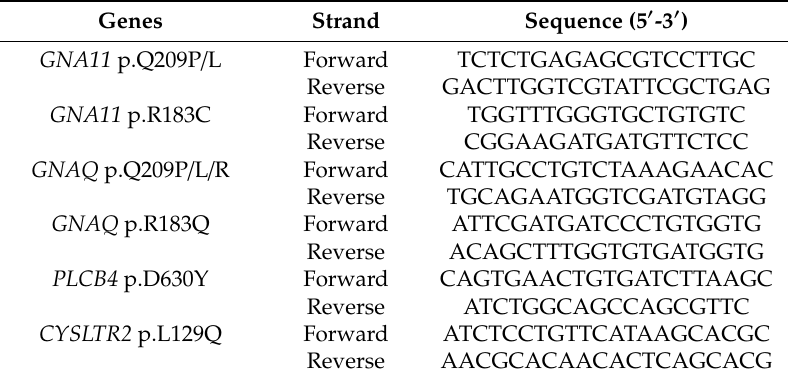
Table 5. Sequences of the PCR and sequencing